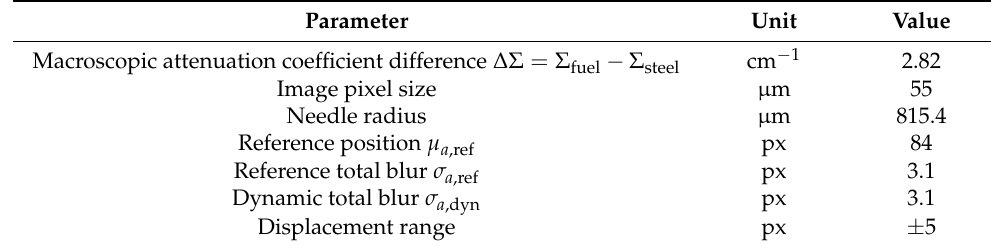
Table 1. Parameters used for time-series displacement